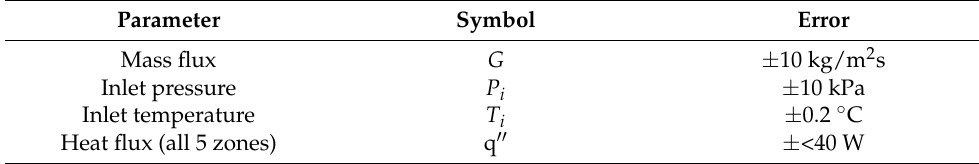
Table 3. Uncertainties of the main operational parameters.